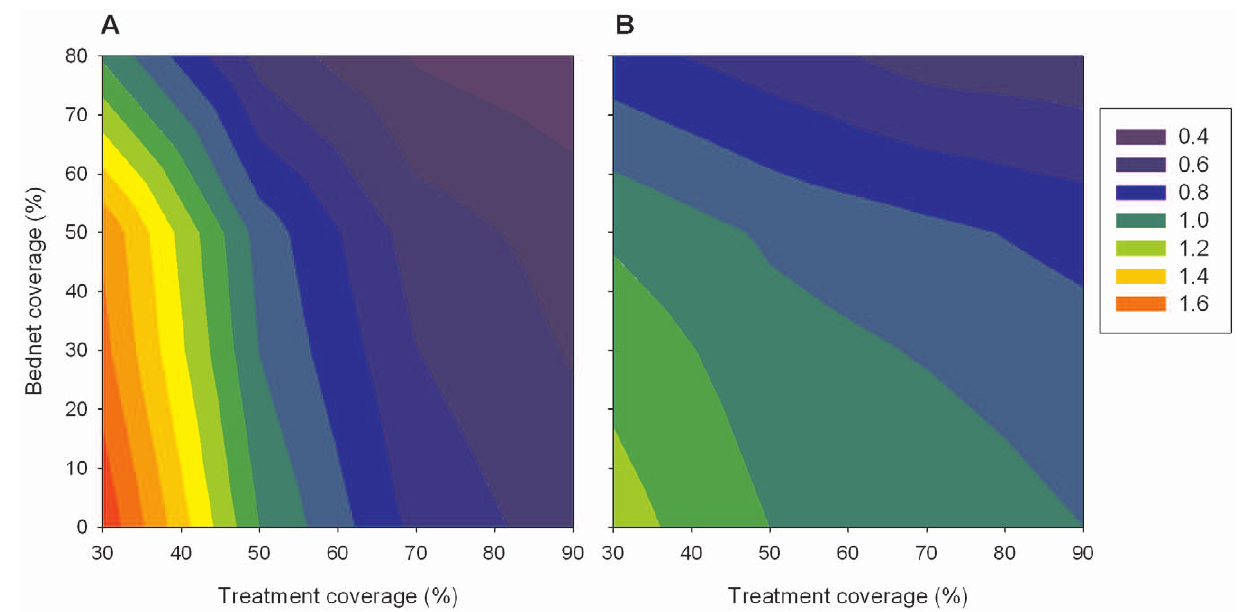
Figure 5. Sensitivity of model output to treatment coverage. Changes in (A) fever and (B) EIR are compared to baseline (50% treatment and 0% bed net coverage). Contours represent the ratio of intervention to baseline 5 years after start of intervention.